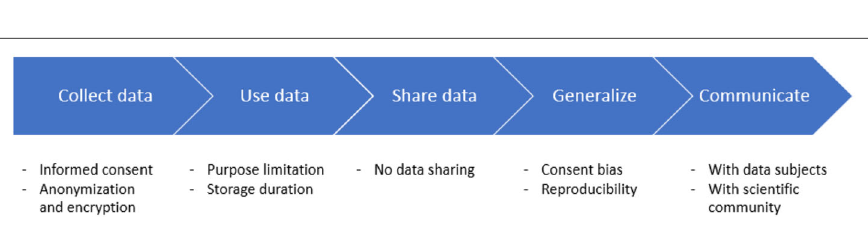
Figure 5 Mockup example of the Facebook Login button and the edit permissions